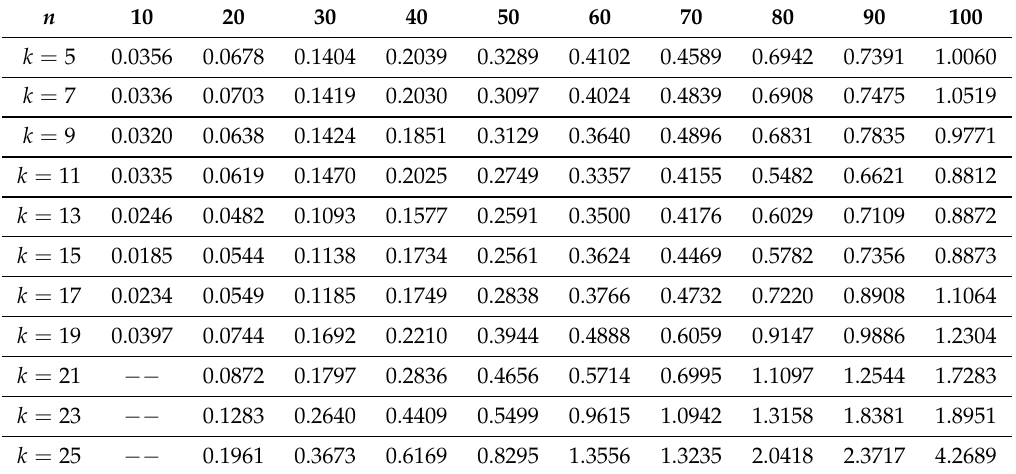
Table 7. Corresponding computation time in different diagonal numbers with dimension n = 10 to 100 of